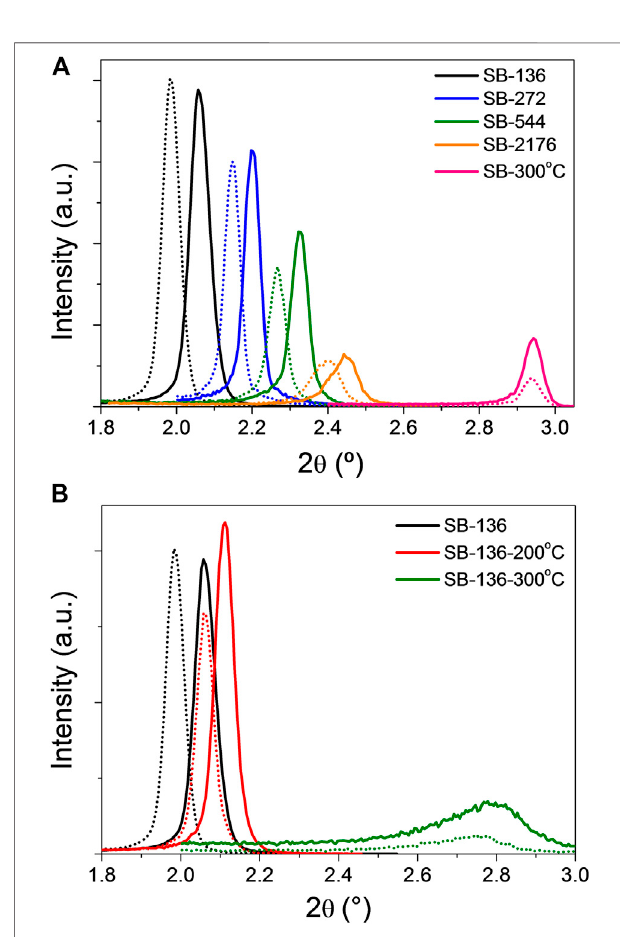
FIGURE 5 | XR diffraction patterns measured at low humidity (5% RH, solid lines) and high humidity (90% RH, dash lines) for (A) SB samples irradiated at different doses and SB-300 ° C and (B) SB-136 system with different additional thermal treatments.